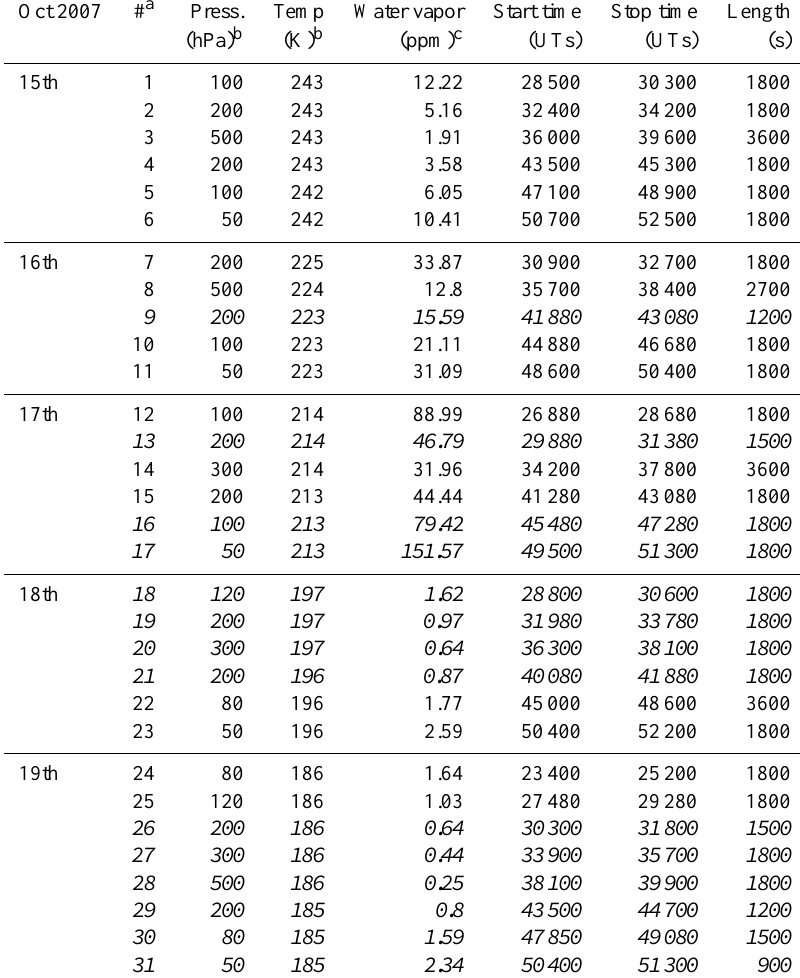
Table 3. Details of AquaVIT-1 static segments used in the accuracy and precision